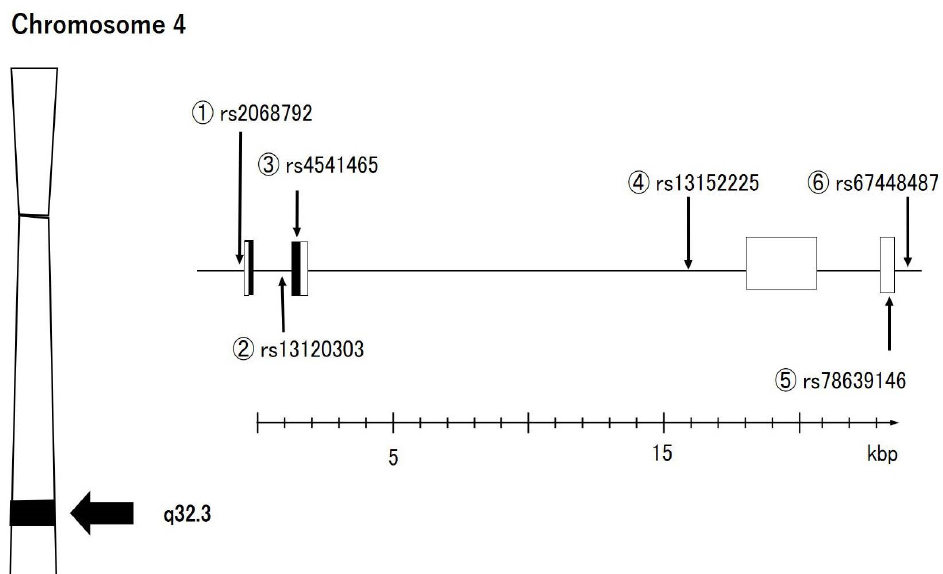
Figure 1. Organization of the APELA gene and location of SNVs. The APELA gene is located on 4q32.3. The arrows indicate the locations of the SNVs. Open and closed boxes indicate untranslated regions and translated regions in exons, respectively. Lines indicate introns.